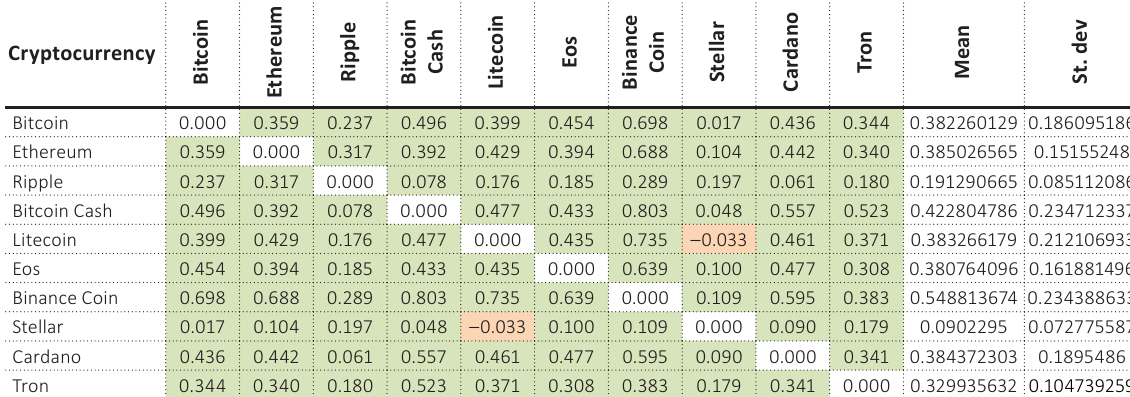
Table 4. Difference in value of correlation coefficients between the periods of increasing and decreasing prices (daily return)